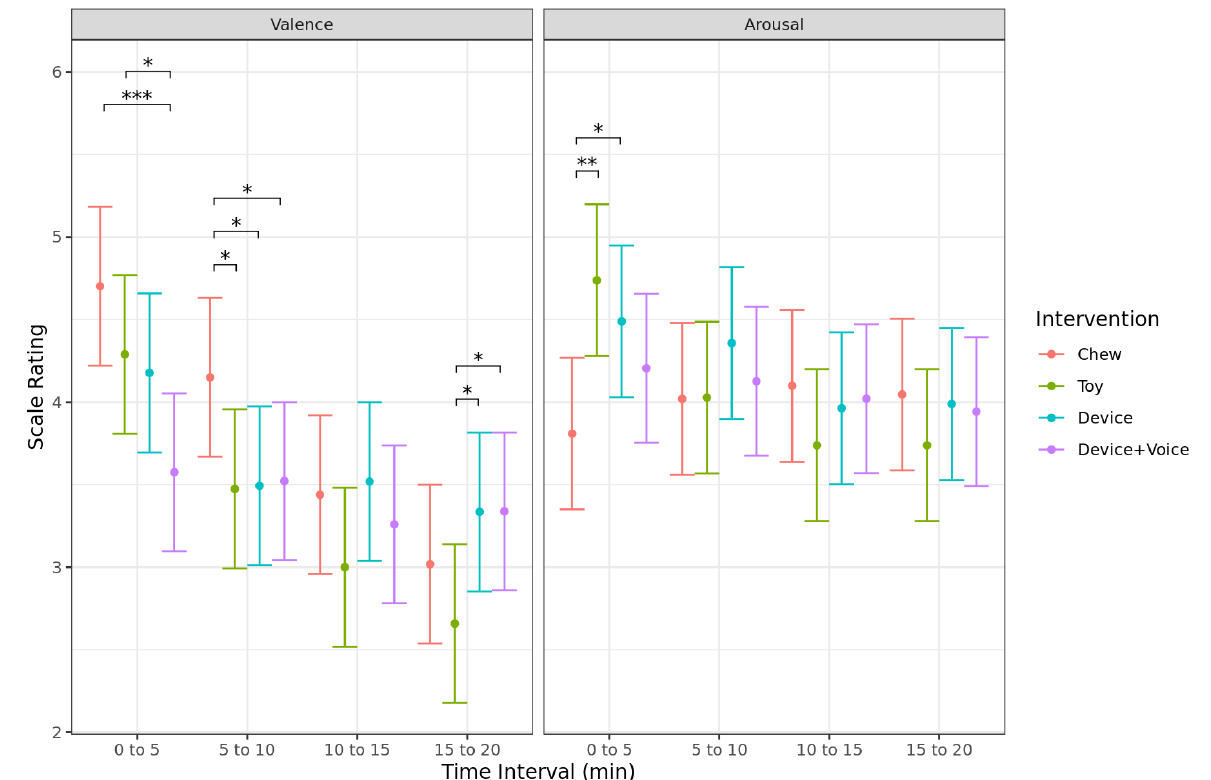
Figure 8. Predicted mean (95% CI) scores for the Valence scale and Arousal scale for each 5 min interval when dogs were left alone with one of four enrichments for 20 min. Asterisks indicate significant differences between treatment groups within each time interval. Three asterisks indicate significance at p < 0.001, two asterisks indicate significance at p < 0.01, and one asterisk indicates significance at p < 0.05.